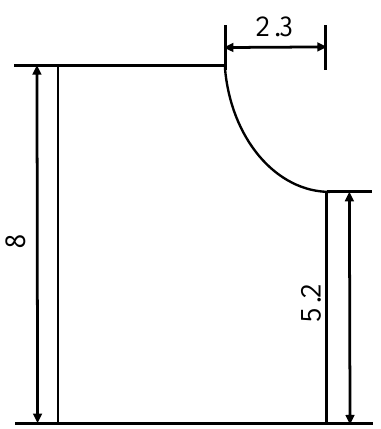
Figure 6. Sketch of the coal wall rib spalling. When Z < 0, that is, the equal section beam that is clamped at one end and simply supported at the other end, take the O point as the coordinate origin, vertically downward as the x -axis, and horizontally to the right as the y -axis, and establish a planar rectangular coordinate system for force analysis, as shown in Figure 7.